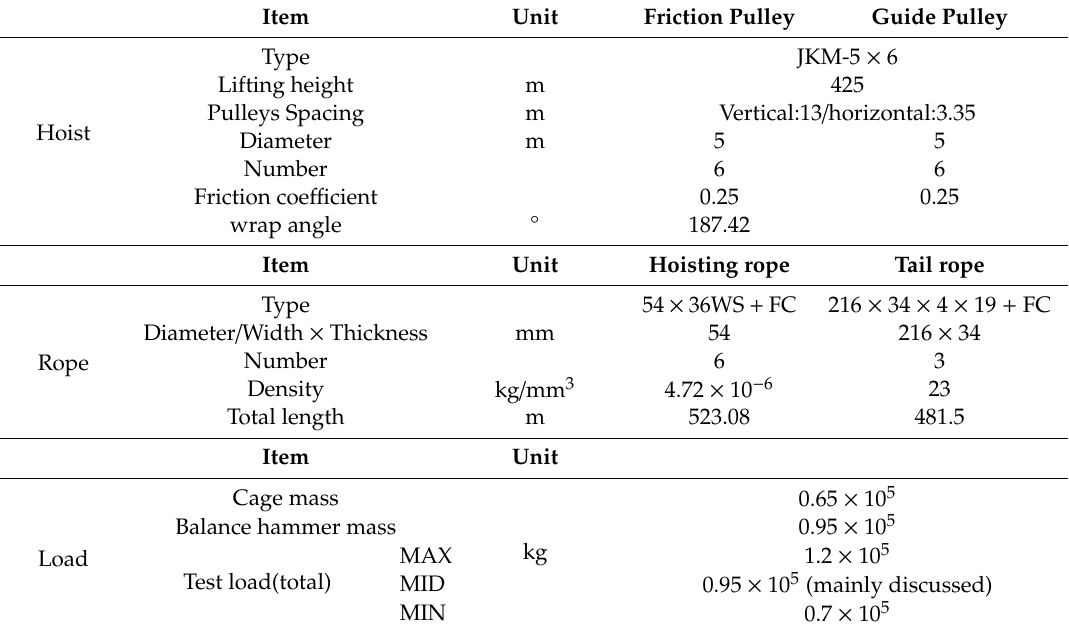
Table 1. Parameters of large cage hoisting system.